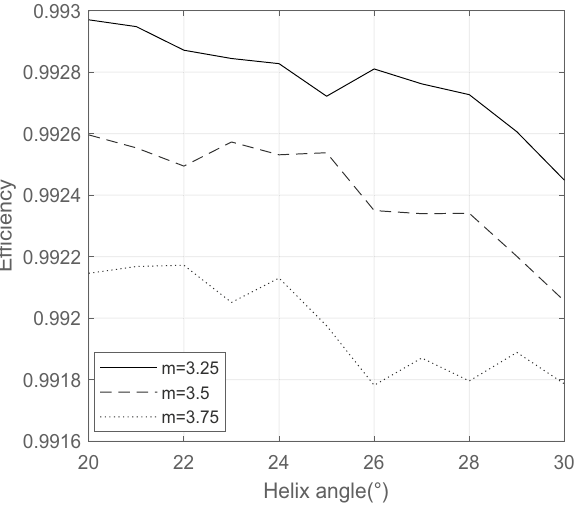
Fig. 21 Efficiency of different modulus and helix angle at equal bending strength of the teeth and pressure angle of